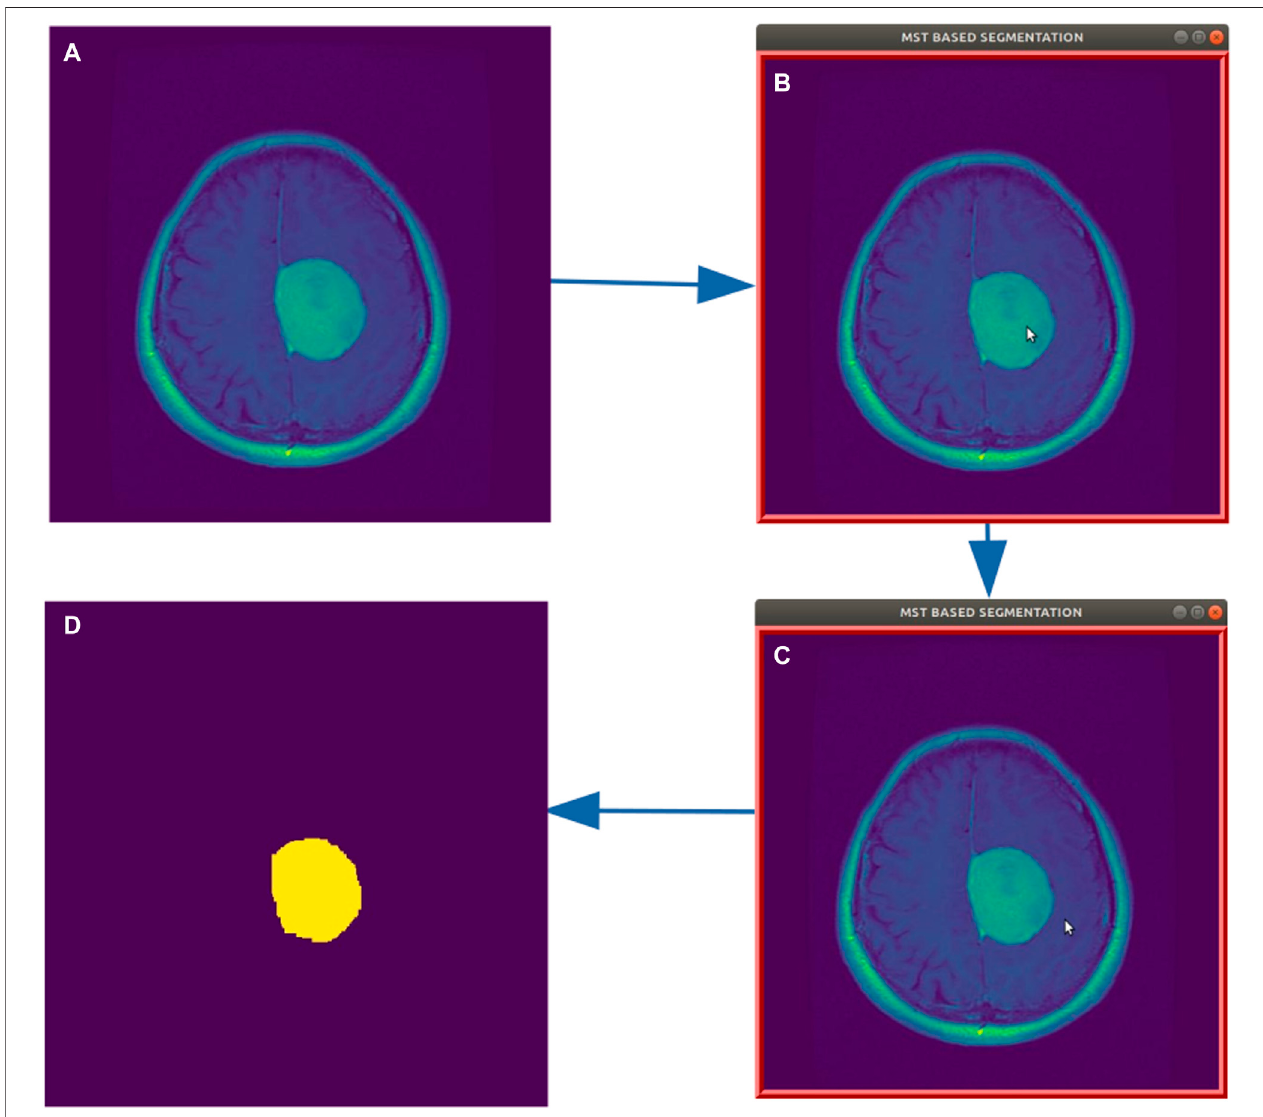
FIGURE 2 | Steps for segmenting a brain tumor. (A) Representative axial MRI section of a brain with a tumor giving a higher intensity signal. (B,C) Interactive window showing a cursor selecting a pixel inside and outside the tumor, respectively. (D) Final segmented tumor.